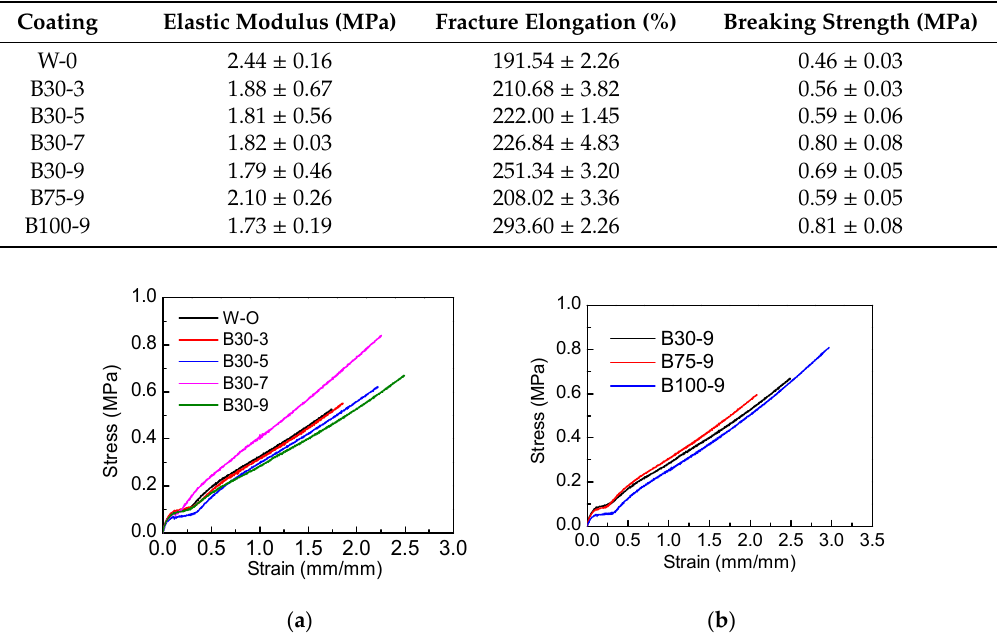
Figure 5. ( a ) The effect of PSO addition amount on stress – strain curve of the silicone topcoat, ( b ) the effect of PSO viscosity on stress – strain curve of the silicone topcoat.